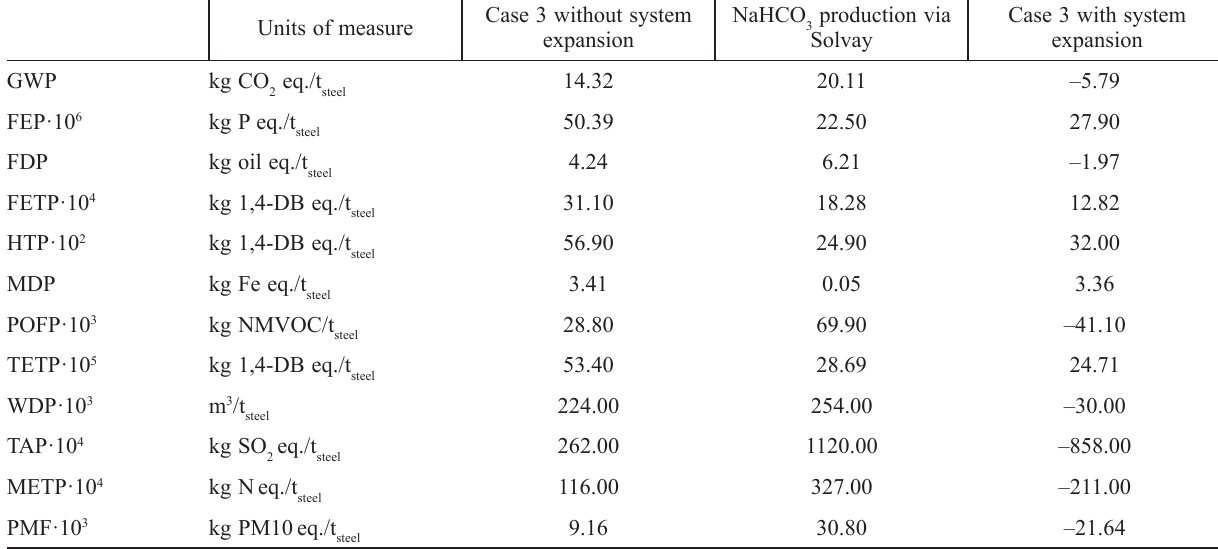
Table 8 – LCIA results for Case 3, with and without system expansion Units of